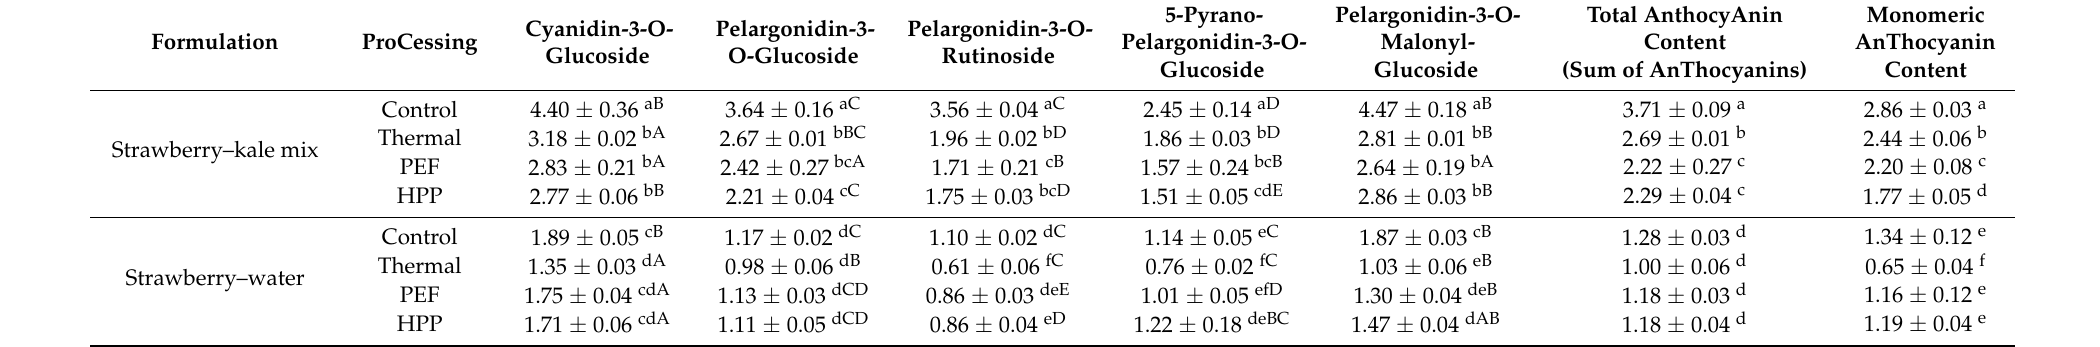
Table 5. Degradation rate constant k ( × 10 − 2 ) of the major strawberry anthocyanins during storage fitting to the first-order kinetic models (n = 3). The coefficient of determination R 2 was above 0.9 for all samples. Capital letters indicate significant differences per row (anthocyanin), and small letters indicate significant differences per column (sample formulation and processing) ( p <